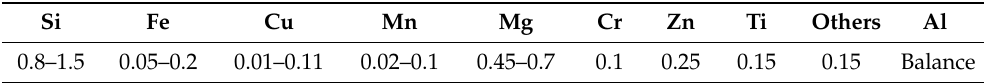
Table 2. Chemical composition of the as-received material (wt. %).